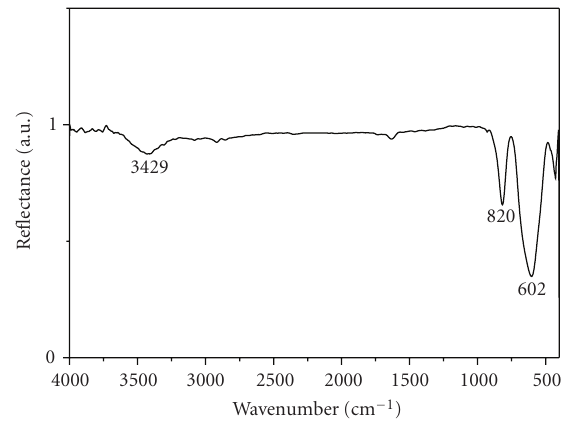
Figure 2: FT-IR spectra of CBTi144 film annealed deposited by the soft chemical method at 700 ◦ C for 2 hours.